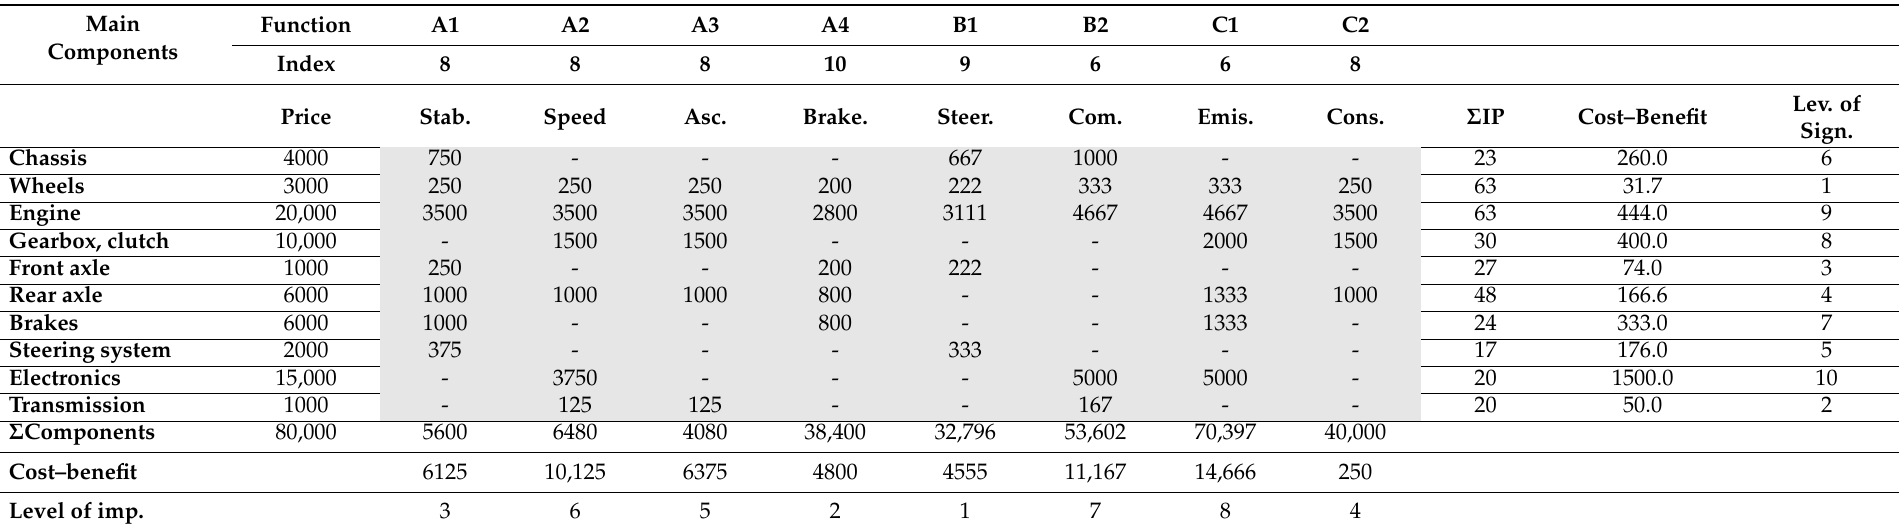
Table 4. Cost–income analysis